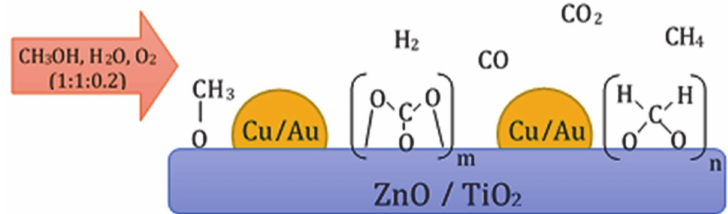
Figure 10. The species formed during the combined reforming of methanol process